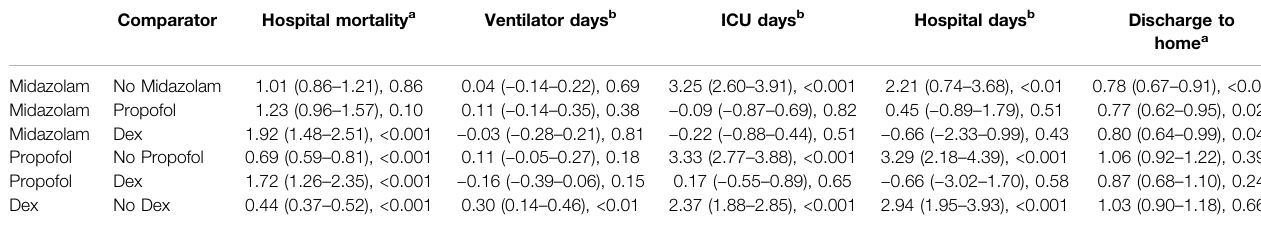
TABLE 2 | Results of propensity-matched analysis in patients with or at risk for acute respiratory distress syndrome.